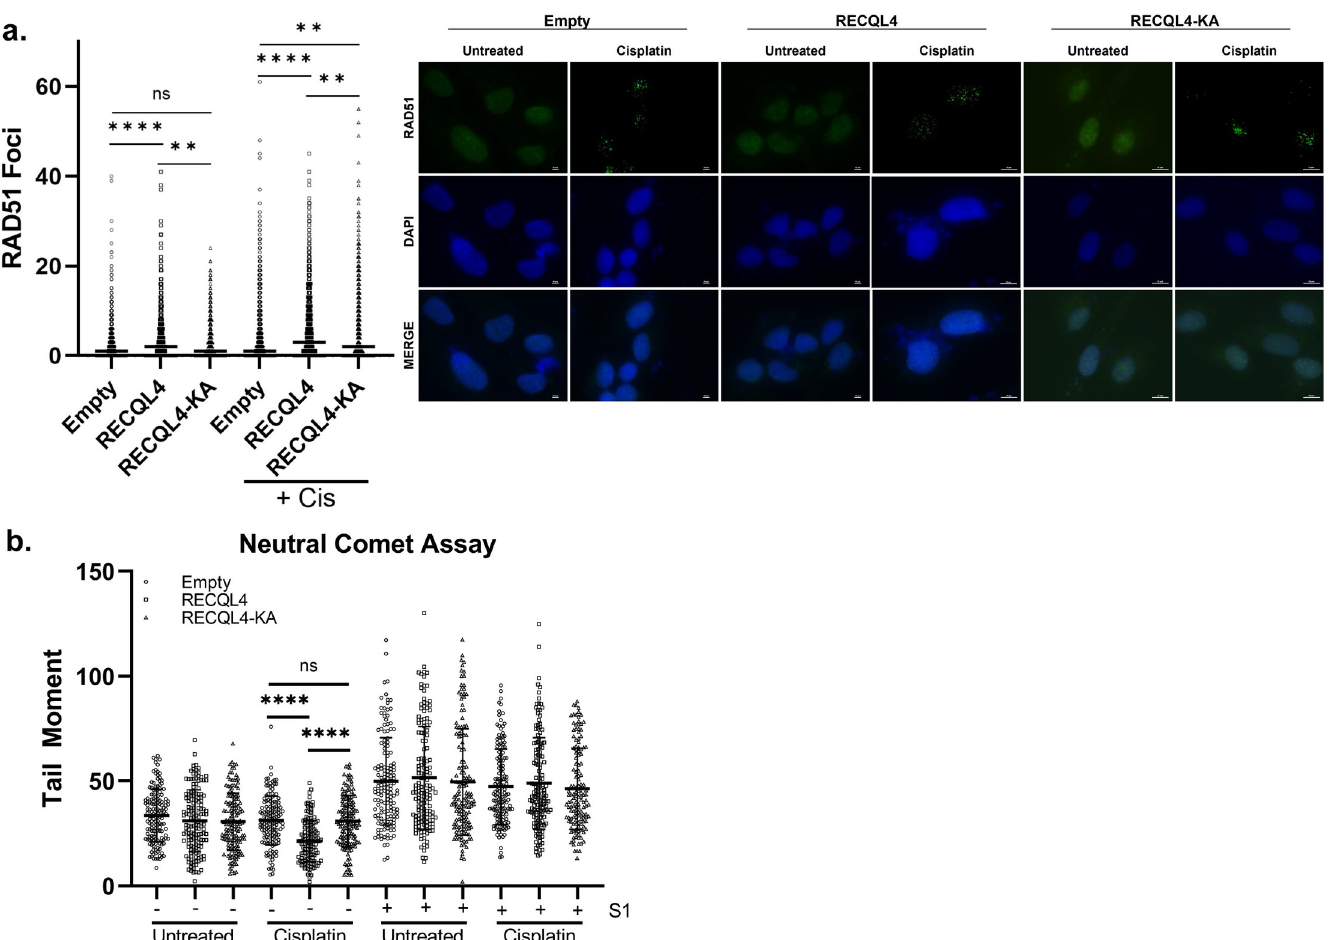
Fig 6. Overexpression of RECQL4 results in increased RAD51 foci and decreased tail moment. (A) Overexpression of RECQL4 results in increased RAD51 foci, which is dependent on its helicase activity. U2OS cells were transfected with an empty plasmid or a plasmid expressing RECQL4 or RECQL4-K508A under a CMV promoter. The cells were either mock or cisplatin treated for one hour and after a two-hour recovery, imaged for RAD51 foci or DAPI by immunofluorescence. RAD51 foci was quantified from 200 cells per condition for each experiment. The experiment was performed three to five times and the median was graphed (Unprocessed foci count in S9 Data ). Representative images are shown. (B) Overexpression of RECQL4 results decreased tail moment following cisplatin exposure, which is dependent on its helicase activity. U2OS cells were treated similarly to the immunofluorescence experiment, before being harvested for neutral comet assay. At least 40 comets were counted per condition for each experiment. The experiment was performed four times and the mean and standard deviation was graphed (Unprocessed tail moments in S10 Data